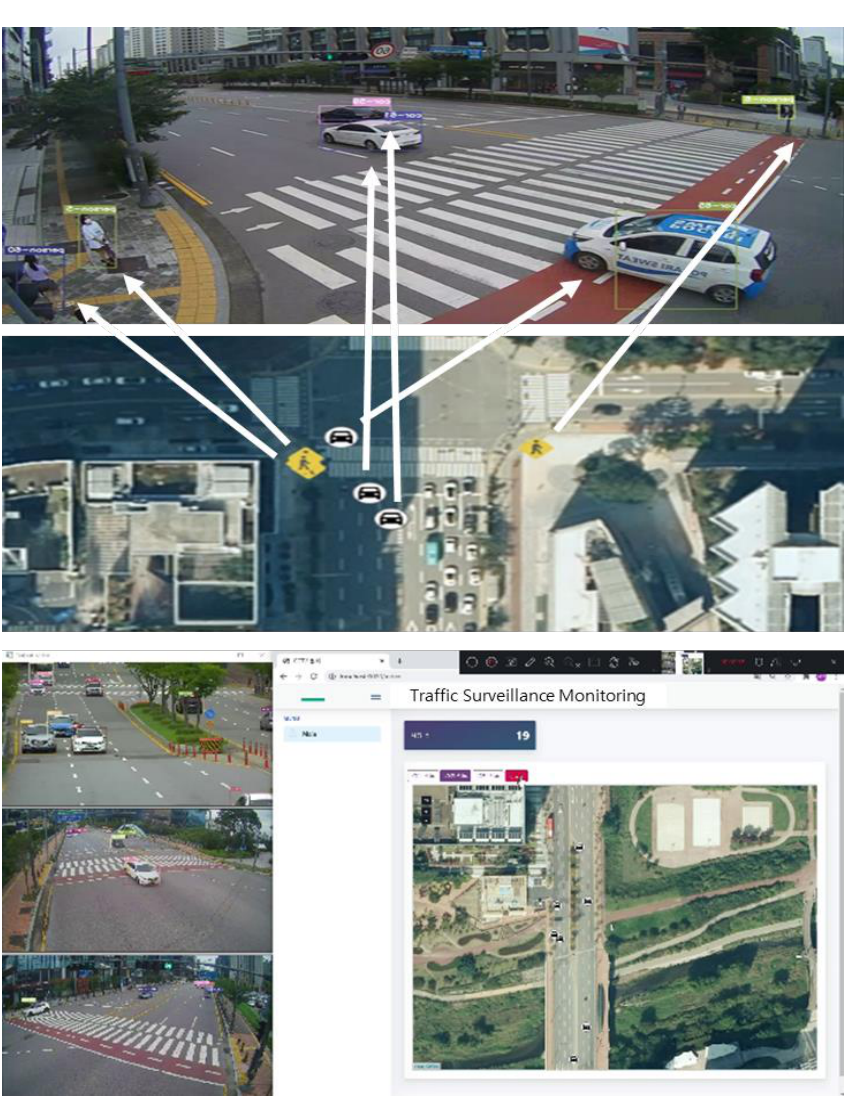
Figure 13. Results of the proposed method.